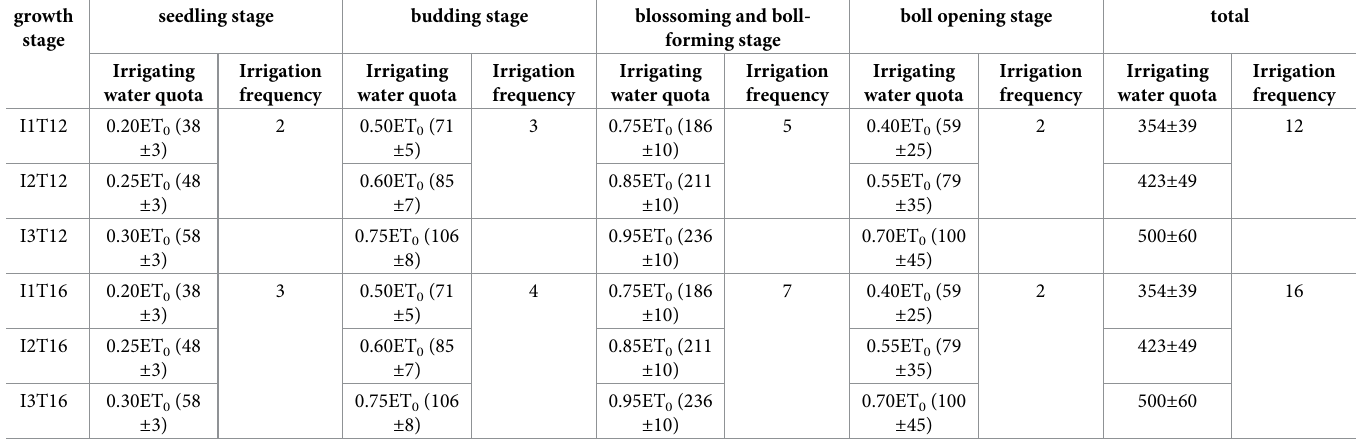
Table 2. Experimental design and irrigation treatment for mulching mulch drip irrigation of cotton in 2012–2015. growth seedling stage